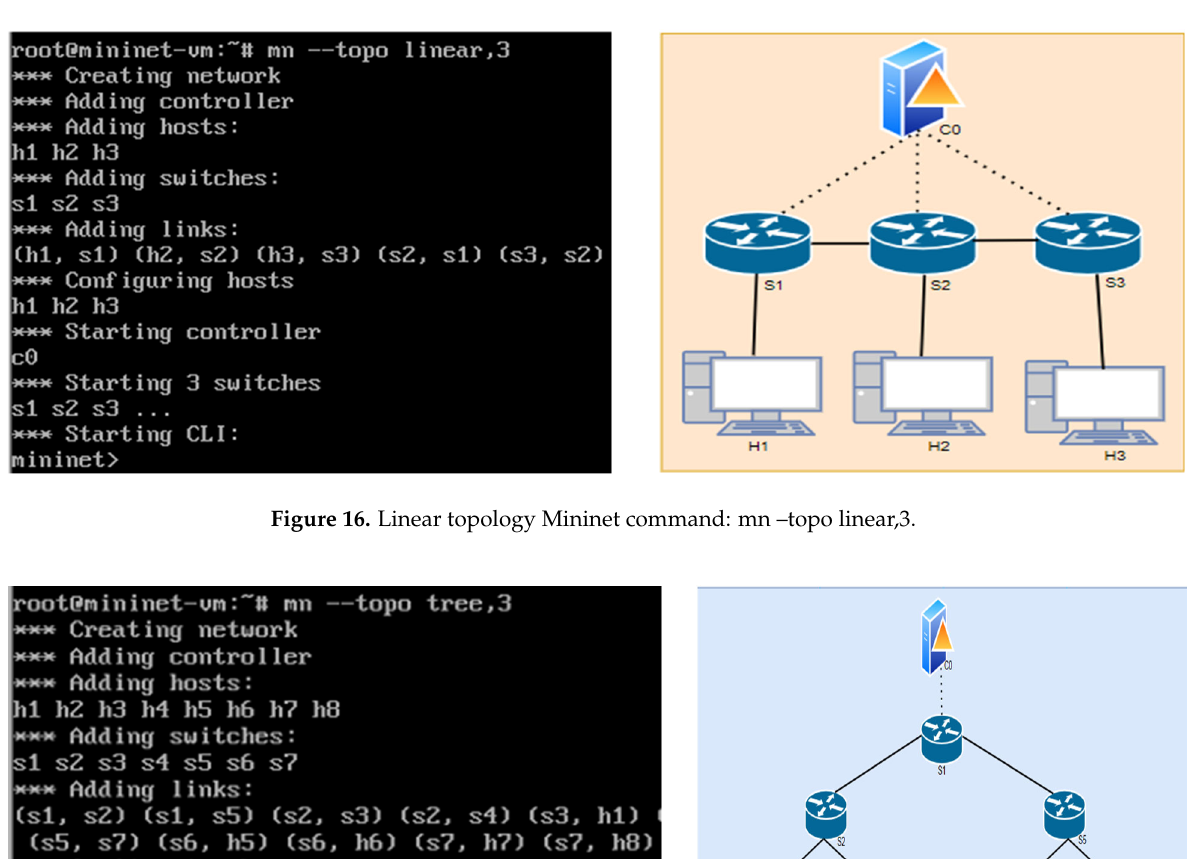
Figure 18. Reverse topology Mininet command: mn ‐‐ topo reversed,3.